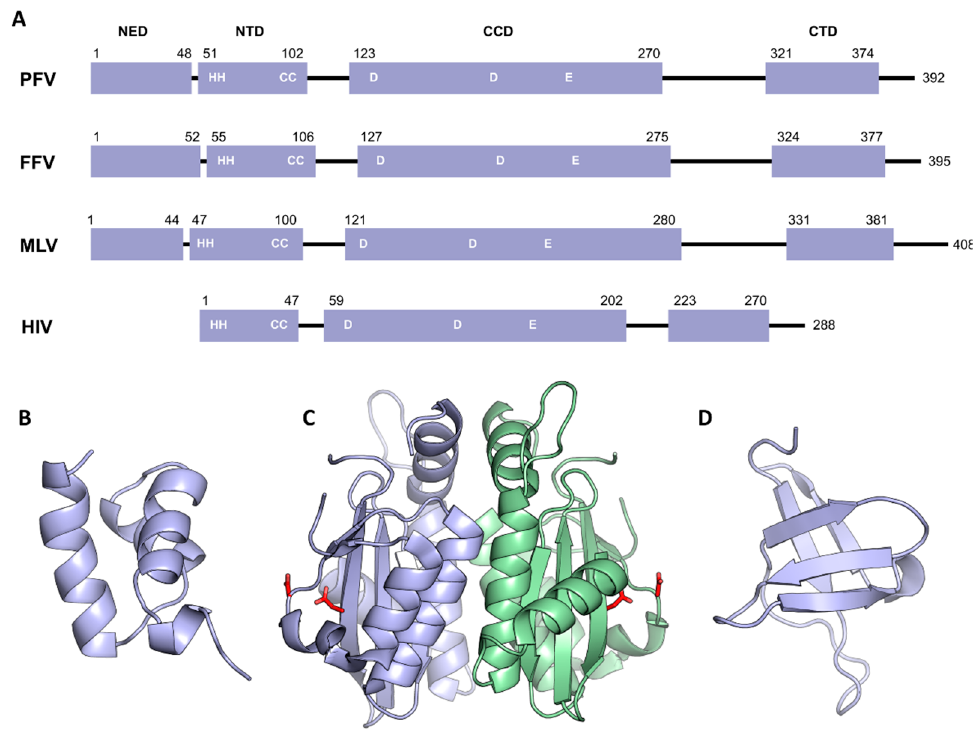
Figure 2. Domain organization of retroviral integrases. ( A ) Schematic of the retroviral IN domain sequences shown as boxes. Isolated domain structures of HIV-1 NTD ( B ), (PDB 1WJC), CCD ( C ), (PDB 1ITG), CTD ( D ), (PDB 1IHV). Chains are shown in cartoon, except active site residues Asp64 and Asp116, which are shown as red sticks (Glu152 residues are disordered and not visible in the